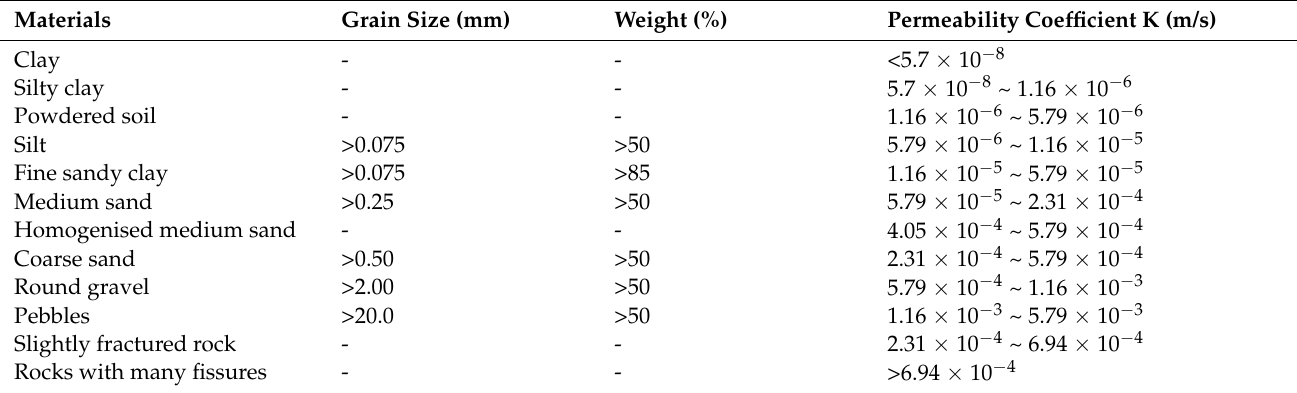
Table A2. Reference infiltration coefficients for different soil types [39].